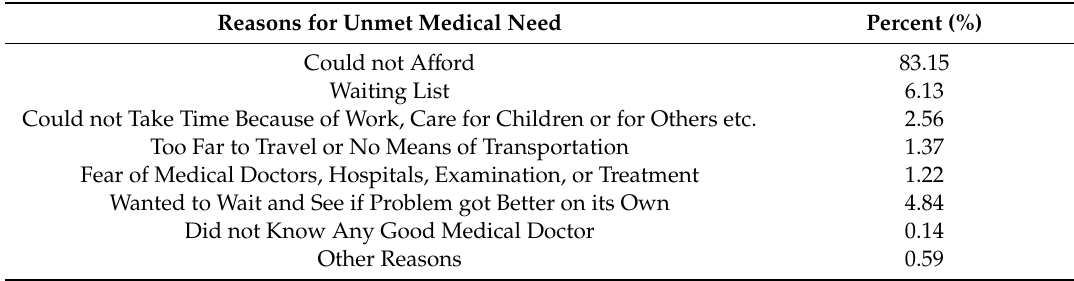
Table 7. Reasons for unmet medical need.